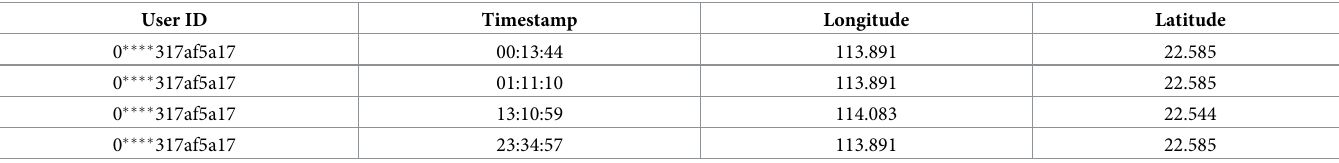
Table 1. Records of one cellphone user in the mobile phone data. User